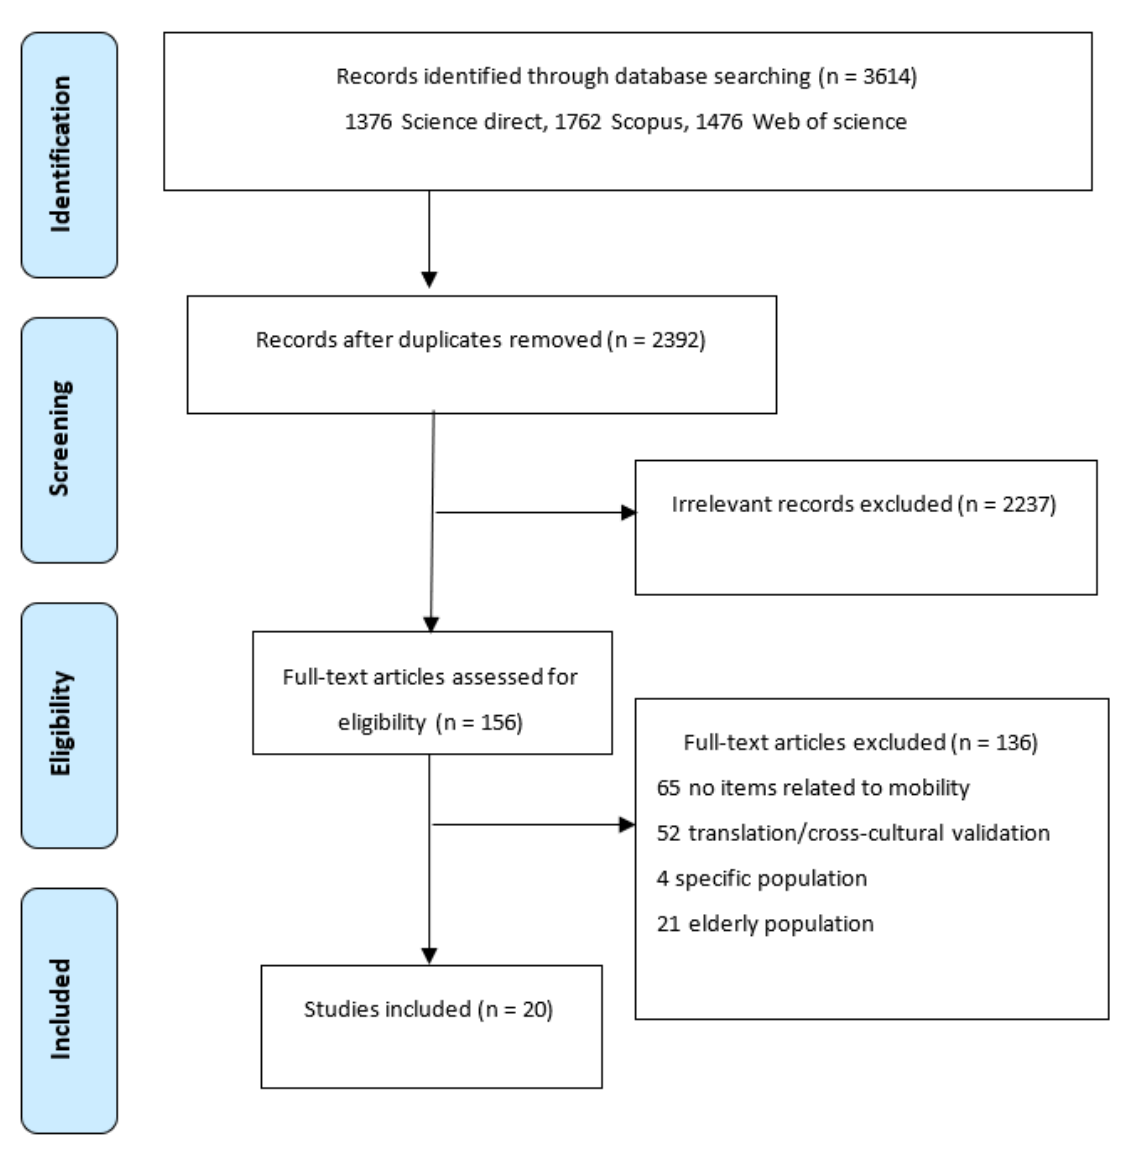
Figure 1. PRISMA flow chart.